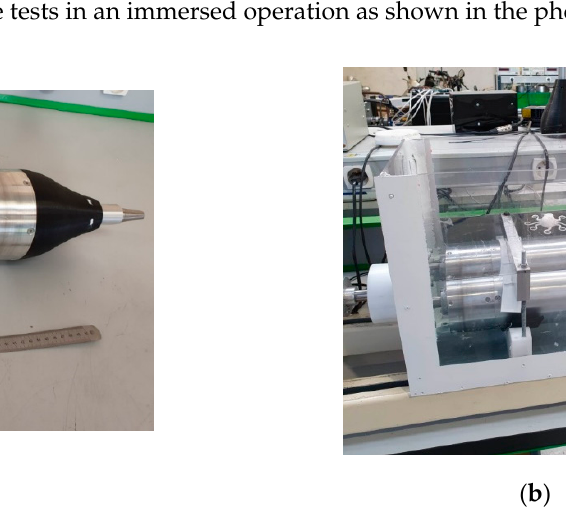
Figure 22. Prototype: ( a ) View of Motor with the sealing flanges, ( b ) Waterproof container.